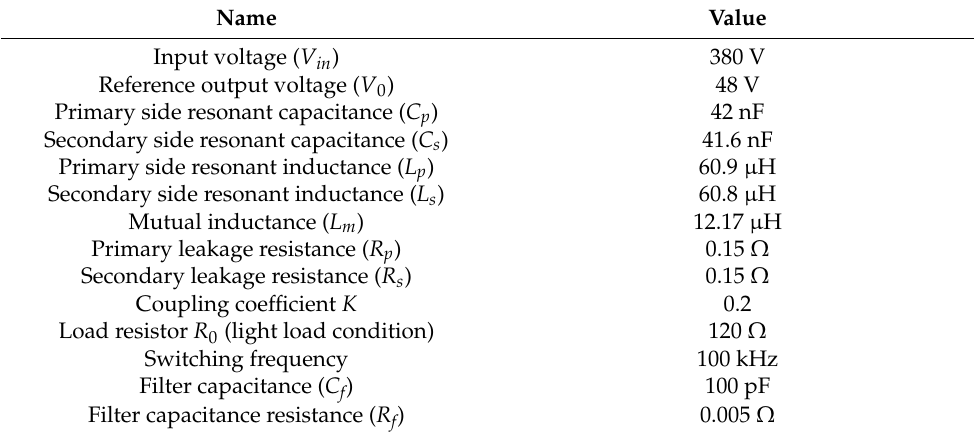
Table 3. Key ratings in main circuit.